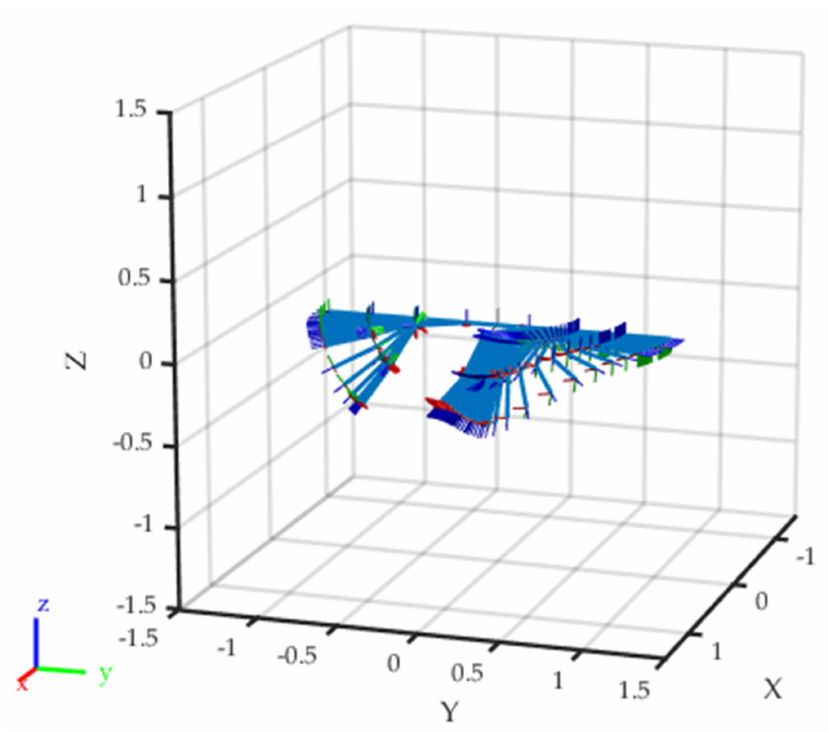
Figure 8. Collision avoidance experiment of the rigid body tree model of the robot.